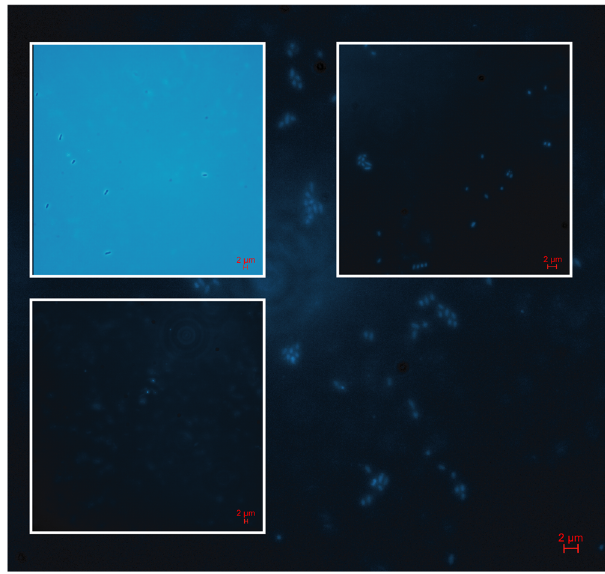
Fig. 8 Epi fl uorescence microscopy of 2-AB-labelled cells recovered from B. cellulosilyticus grown on GH26-AcGGM and AcAGX. Main body — Clusters of 2-AB-labelled cells grown on GH26-AcGGM (positive). Inset bottom left — View of equivalent unlabelled cells (negative). Inset top left — Bright fi eld view of equivalent unlabelled cells (negative). Inset top right — Clusters of 2-AB-labelled cells grown on AcAGX